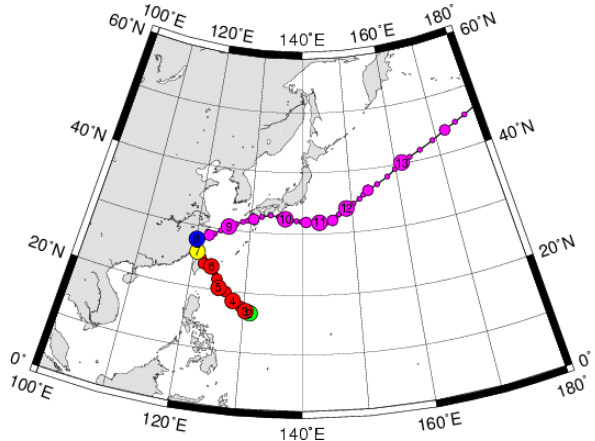
Figure 2. The track of Typhoon Krosa. The colored circles show the strength and location of the Fig. 2. The track of Typhoon Krosa. The colored circles show the typhoon center. The number inside represents the date of occurrence. (Color code: Magenta : Extratropical Cyclone; Blue : Tropical Depression; Green : Tropical Storm; Yellow : Severe strength and location of the typhoon center. The number inside rep- Tropical Storm; Red : Typhoon.) resents the date of occurrence (color code: Magenta: Extratropical Cyclone; Blue: Tropical Depression; Green: Tropical Storm; Yel- low: Severe Tropical Storm; Red: